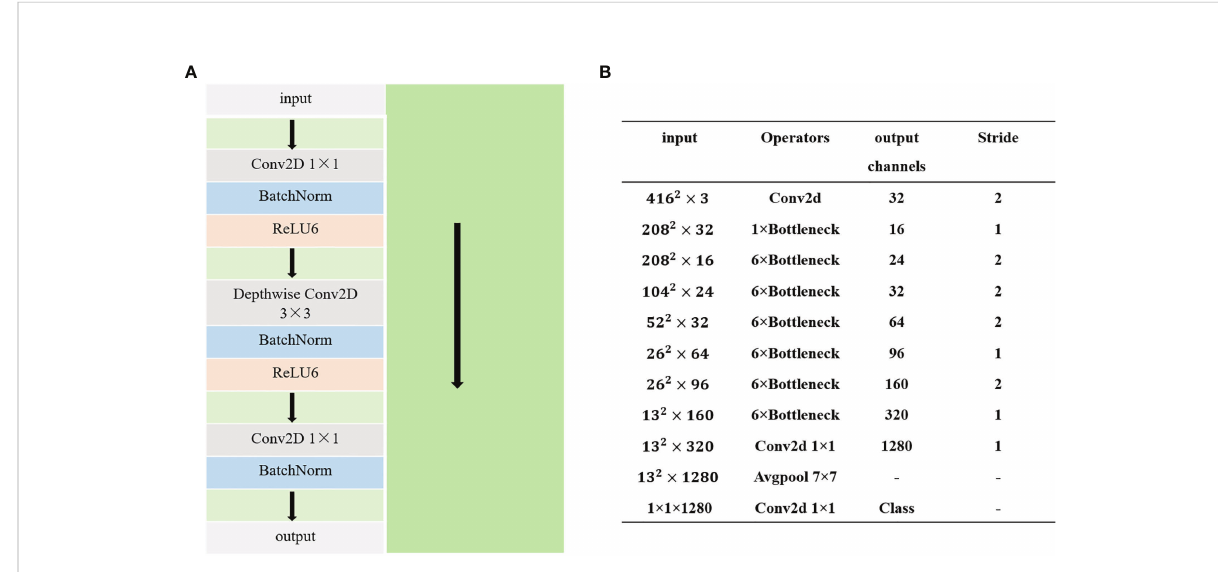
FIGURE 4 Inverse residual structure (A) and structure of MobileNetv2 (B)